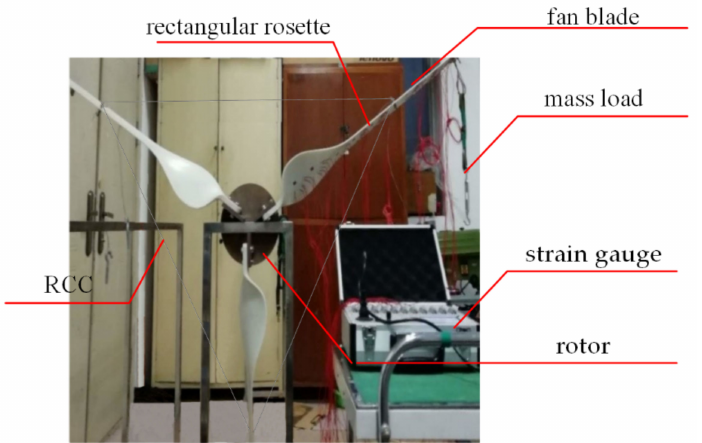
Figure 13. Diagram of test